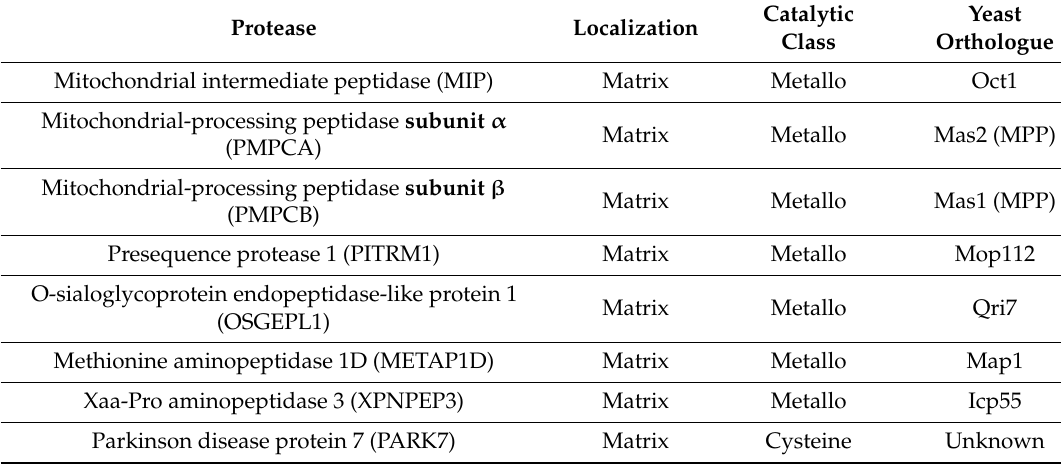
Table 3. Mammalian resident mitoproteases involved in MPQC. Oct1, Octapeptidyl